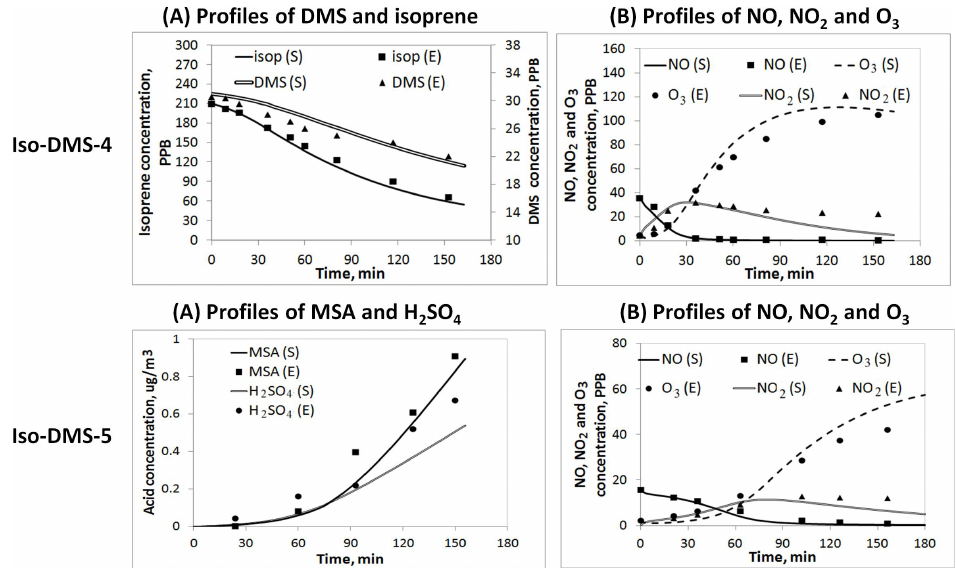
Fig. 5. Time profiles of Exp iso-DMS-4 (isoprene, DMS, NO x and O 3 from the photooxidation of 31ppb of DMS and 40ppb of NO x in the presence of 210ppb of isoprene) and time profiles for Exp iso-DMS-5 (NO x , O 3 , MSA and H 2 SO 4 from 20ppb of DMS and 15ppb of NO x in the presence of 40 ppb of isoprene). “E” denotes the experimentally observed concentrations of chemical species and “S” for those simulated using the kinetic model. The decay of DMS and isoprene was not corrected for the wall loss and chamber dilution while the production of MSA and H 2 SO 4 was corrected for wall